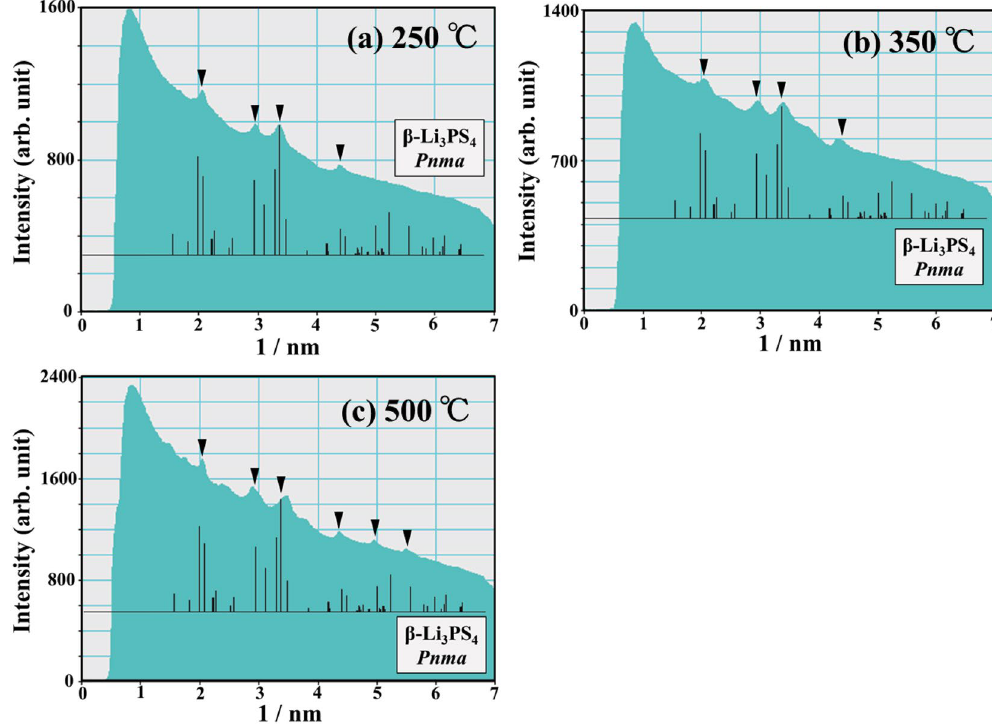
Figure 7. The intensity profiles of the ED patterns at ( a ) 250 °C, ( b ) 350 °C, and ( c ) 500 °C, which were taken from the LPS region without interfacial contact with